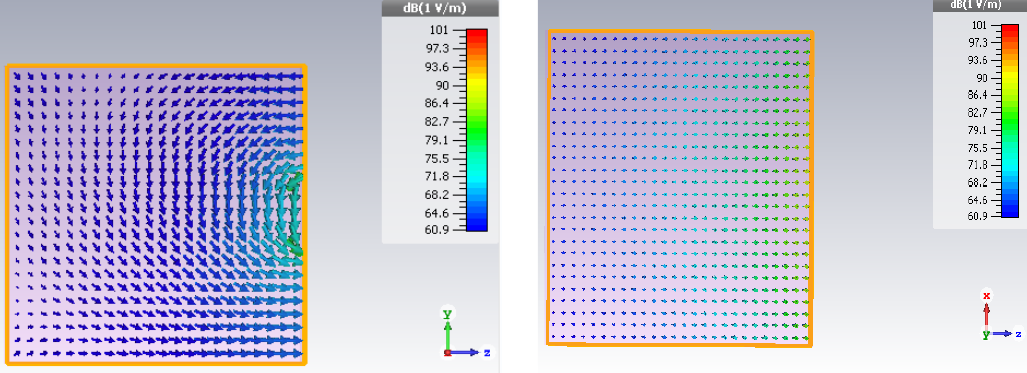
Figure 3. E-field distributions within the rectangular DRA coupled to an ES.